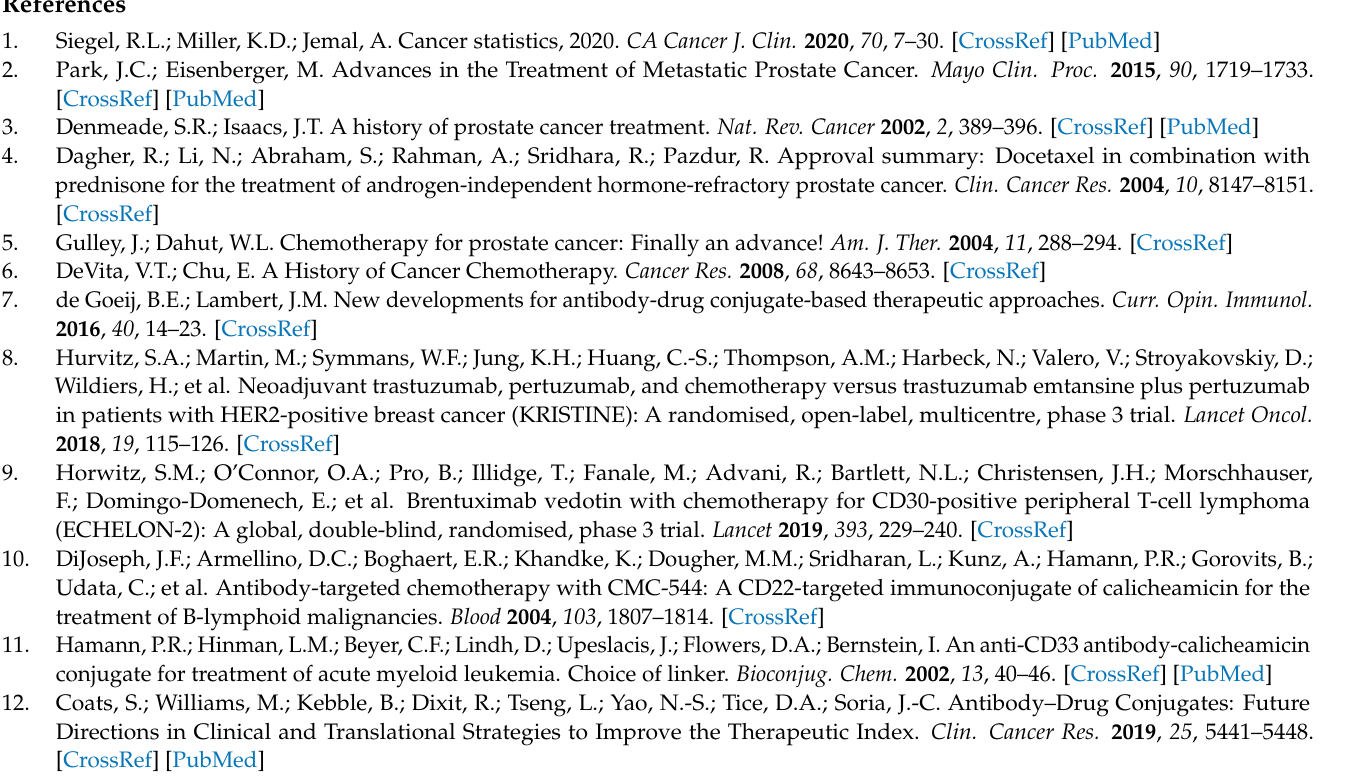
tail vein injection. Figure S5. Histological examination of major organs treated by 3820 nmol/kg of PSMA-1-VcMMAE. Figure S6. PSMA-VcMMAE (384 nmol/kg), MMAE (700 nmol/kg) and PSMA-ADC (50nmol/kg) showed comparable antitumor activity against heterotopic PC3pip tumors for 30 days. Table S1. Comparison of therapeutic index of PSMA-1-VcMMAE, MMAE and PSMA- ADC. Figure S7. PSMA-1VcMMAE-Cy5.5 is more potent for killing heterotopic PC3pip tumor than for heterotopic PC3flu tumors. Figure S8. PSMA-1-VcMMAE was effective in heterotopic C4-2 tumor model. Figure S9. Establishment of metastatic PC3pipGFP tumor model. Figure S10. Mass spectrum of PSMA-1-VcMMAE, PSMA-1-VcMMAE-Cy5.5 and PSMA-1-McMMAE-Cy5.5. Figure